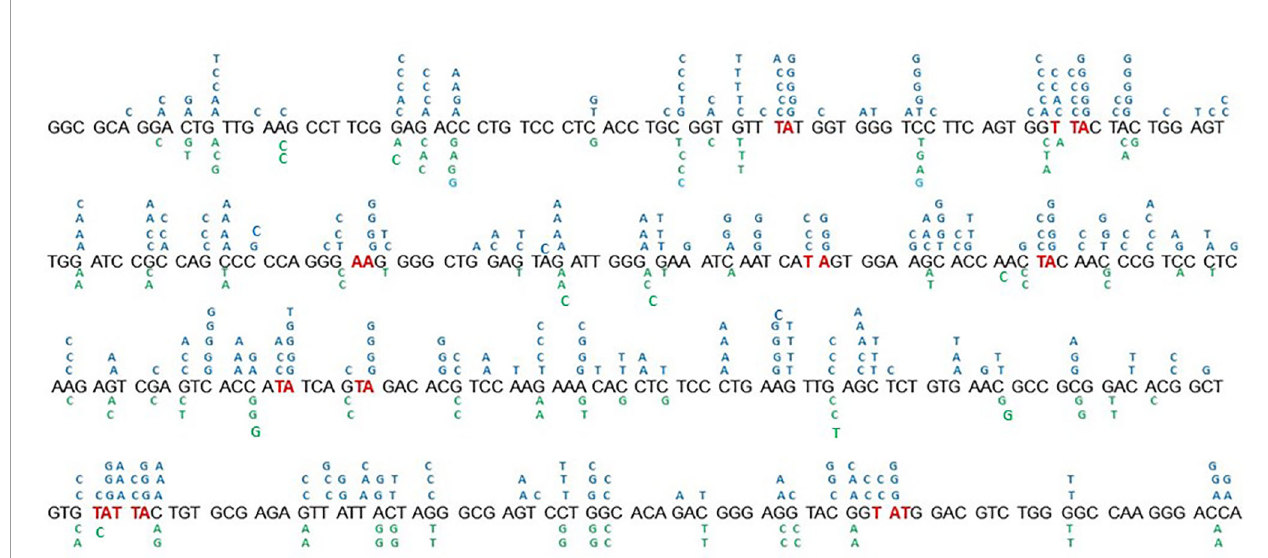
FIGURE 5 | Distribution of point-mutations along the ampli fi ed Ramos VH region. Independently occurring base substitutions are indicated at each nucleotide position. The Pol h hotspots (WA/TW) targeted following the expression of mUb-PCNA are in indicated in red. The fi gure represent the pool of base substitution obtained from the clones indicated in Table 2A . The Nucleotide Substitutions in blue indicated above the Ramos VH sequence are from the 5 clones expressing mUb-PCNA and those below in green are from the fi ve control clones.